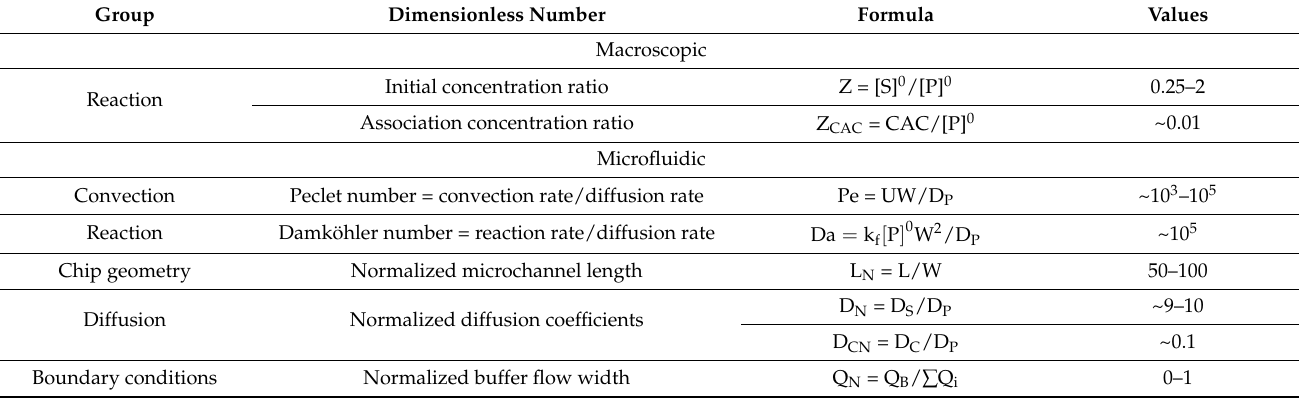
Table 1. Dimensionless numbers for reactive microchannel flows of PAA-CTAB and